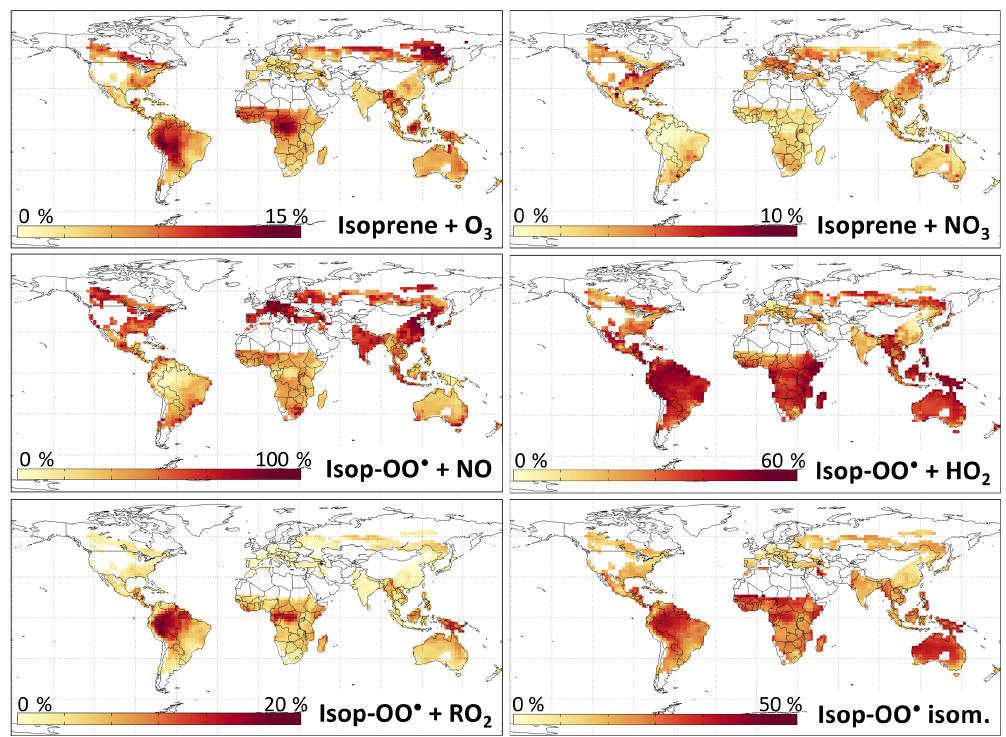
Figure 4. Percent of isoprene reacting with O 3 and NO 3 , and percent of the products from the reaction of isoprene with OH (ISOPOO radi- cals) reacting via each pathway. Values are annual averages from the reduced Caltech isoprene mechanism (RCIM) as implemented in GEOS- Chem and for the bottom 1km of the troposphere. Grid boxes with an average isoprene oxidation rate of < 1 × 10 6 moleculescm − 3 s − 1 are excluded. Note the different scales for each